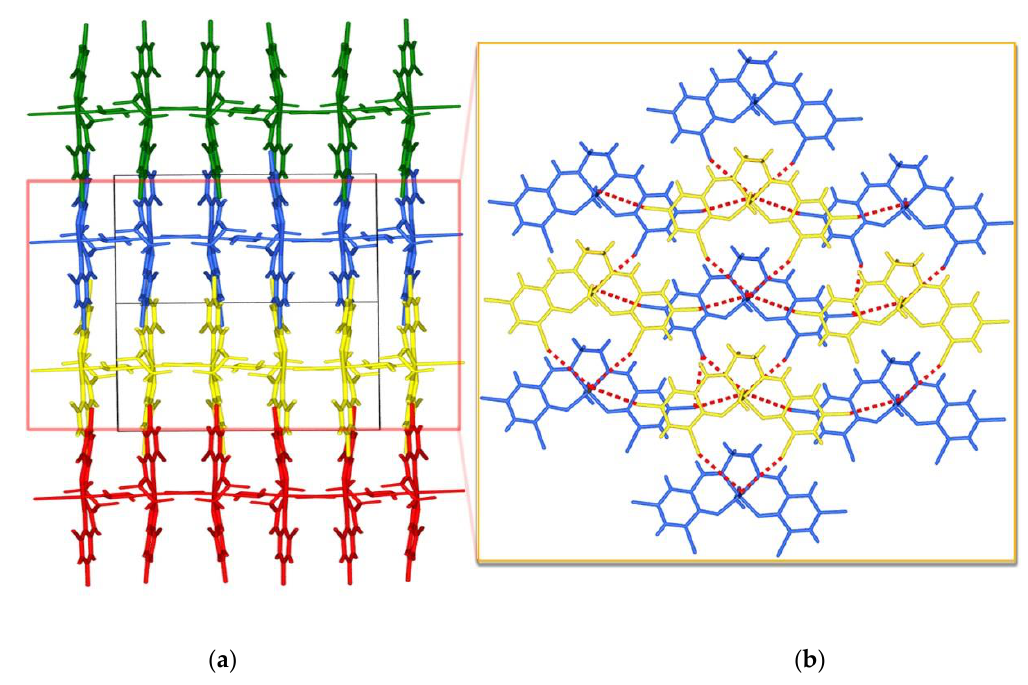
Figure 9. The packing configurations of 1 ( a ) 3-dimensional network ( b ) 3-dimensional structure constructed by means of the aggregation behavior fueled by hydrogen bonding. Color code: red dashed lines represent the intermolecular C-X ··· Cl-Mn hydrogen